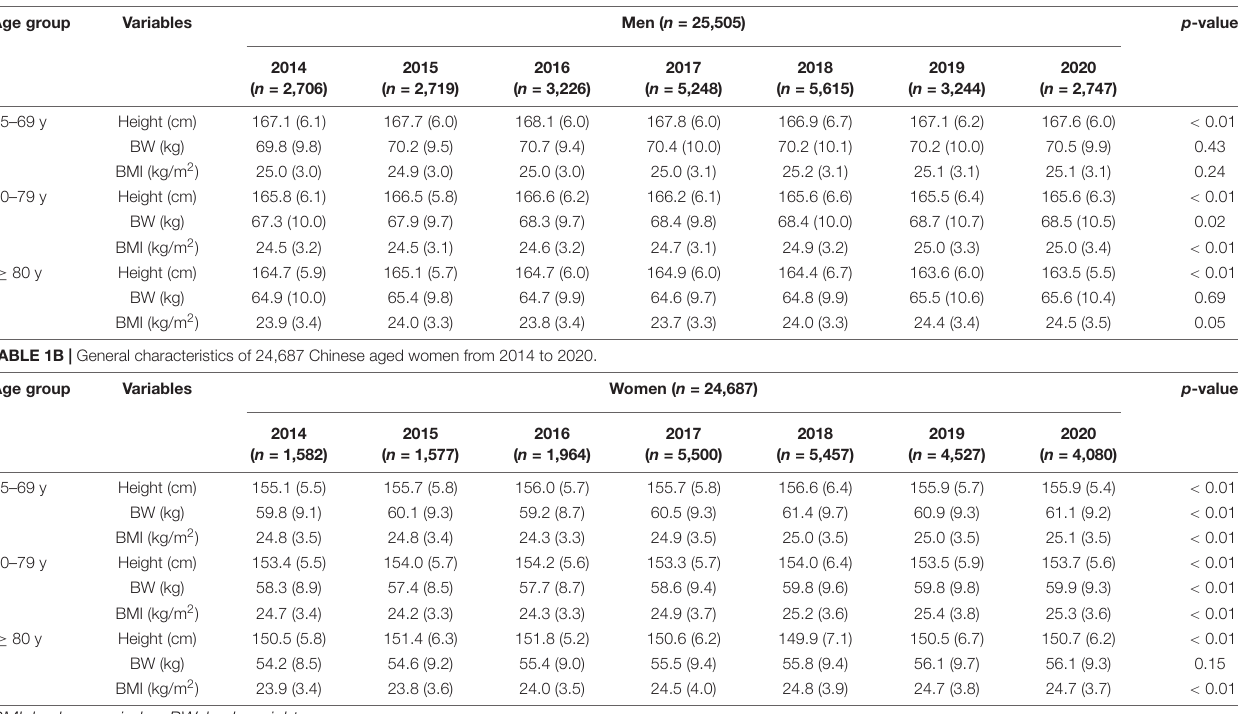
( Table 2 ). For subgroup analysis, similar secular differences in height and body weight were confirmed in each individual year ( Supplementary Table 1 ).